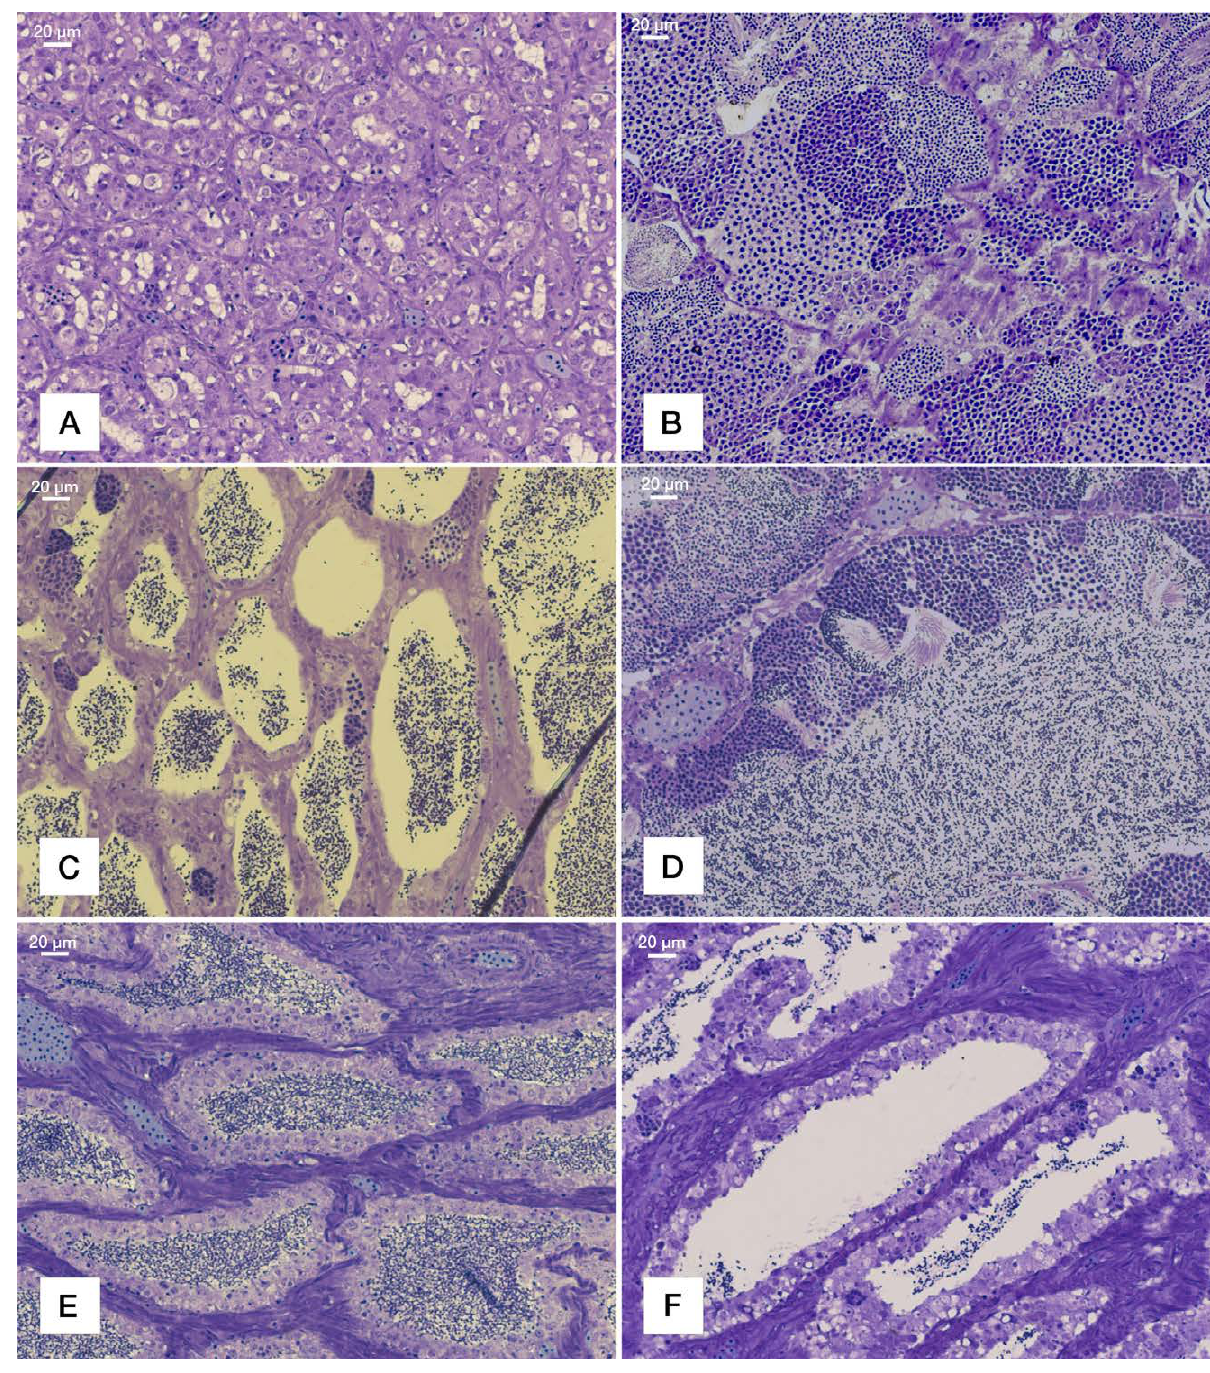
Fig. 8. – Histological phases of the meagre reproductive cycle. [TL, total length in cm; M, month of capture; P, place of capture, southern coast (SC) or Tagus Estuary (TE); Ma, Macroscopical phase]. A, immature [TL, 51; M, March; P, TE; Ma, not determined]; B, developing [TL, 70; M, April; P, TE; Ma, not determined]; C, spawning-capable (virgin) [TL, 59; M, June; P, TE; Ma, Anatomical class I]; D, spawning-capable (mature) [TL, 100; M, May; P, TE; Ma, Anatomical class III]; E, regressing [TL, 127; M, September; P, SC; Ma, Anatomical class IV]; F, regenerating [TL, 144; M, October; P, SC; Ma, Anatomical class IV]. Scale bar, 20 μm, 200 ×